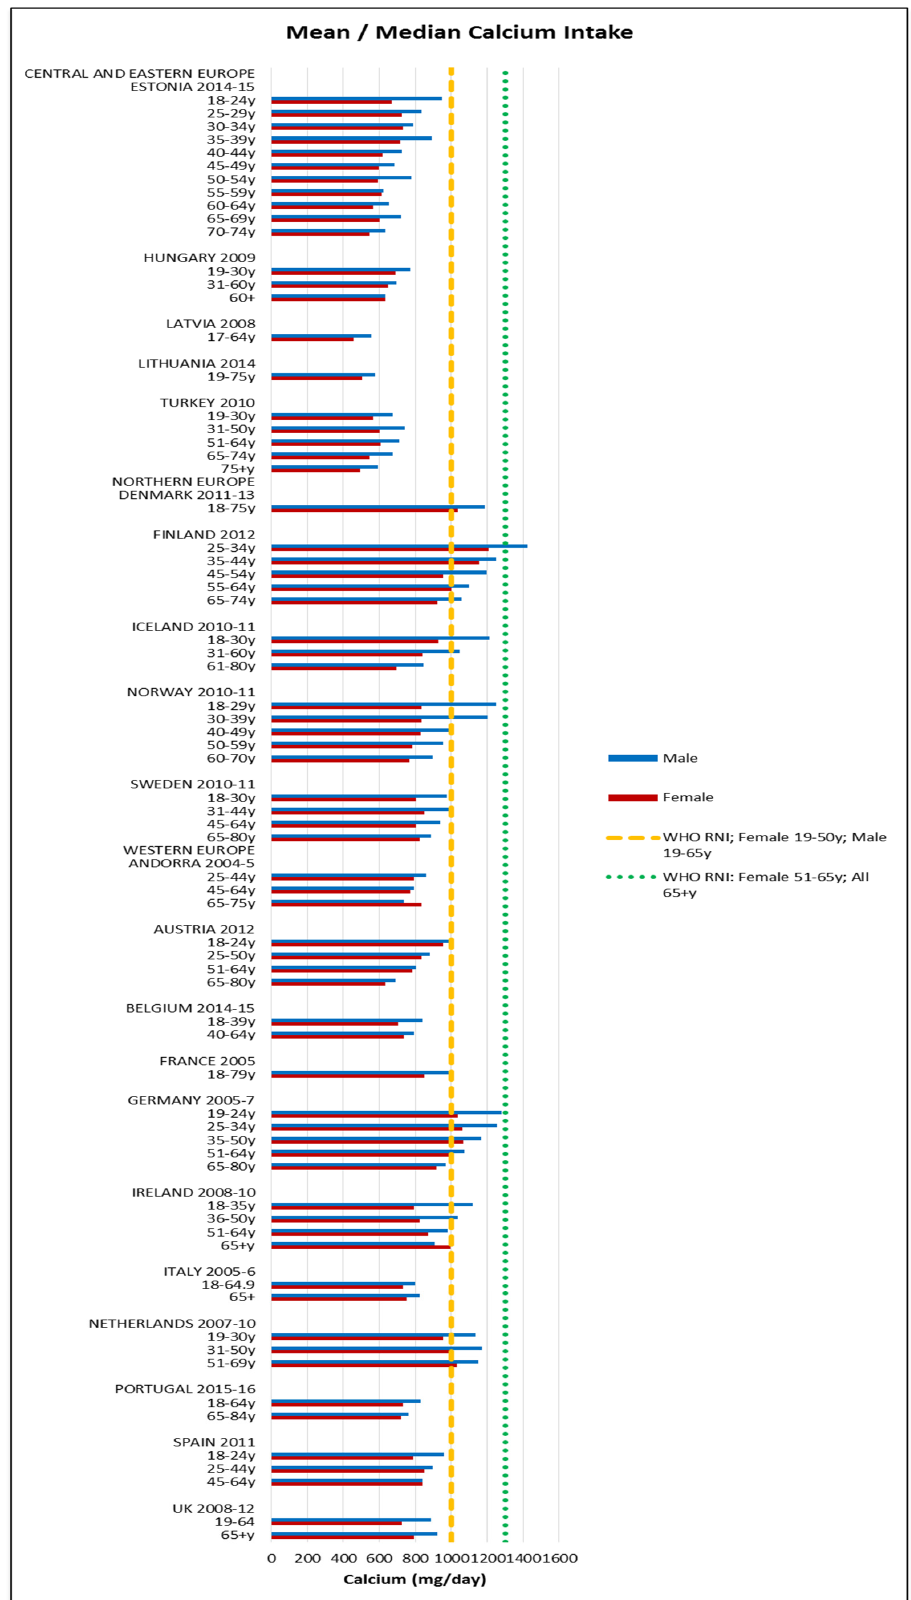
Figure 15. Mean/median* adult calcium intake (mg/day) (excluding supplements). * Figures for Spain are based on median rather than mean values.